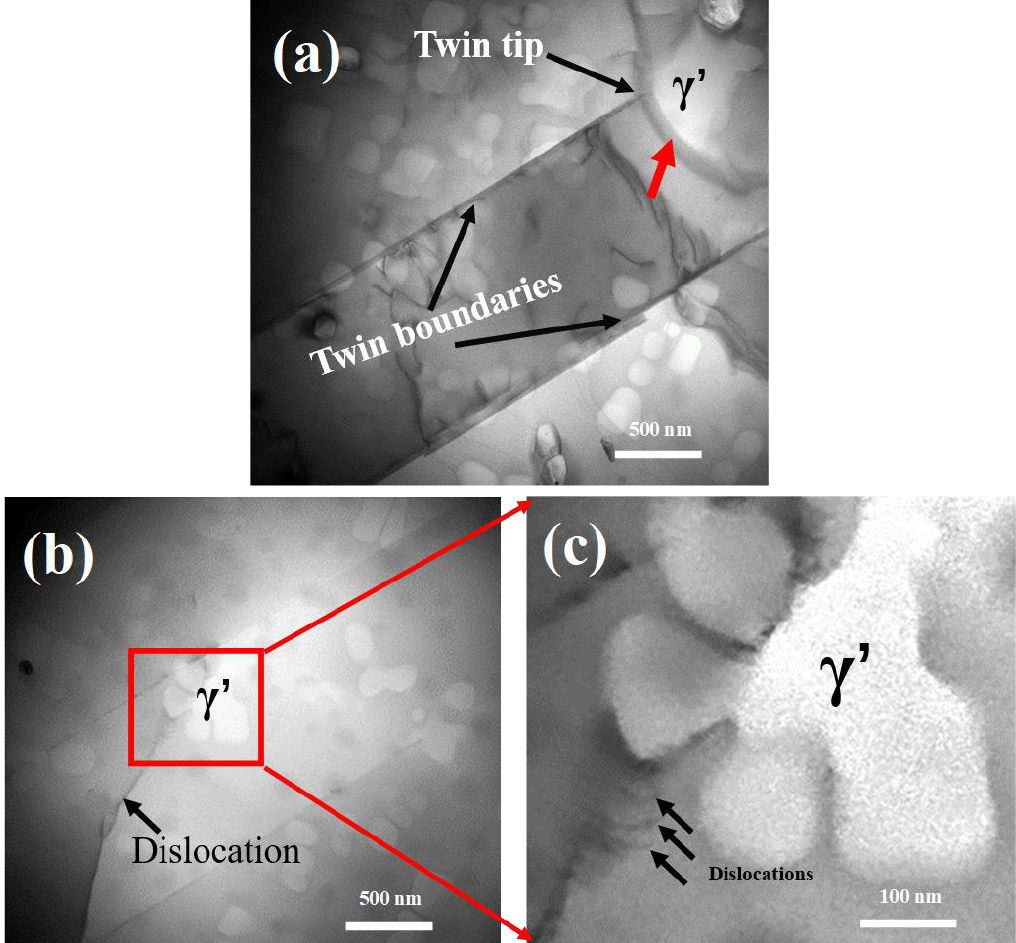
Figure 7. TEM images of FGH96 alloy after cooling to 1000 °C with cooling rate of 6 °C/min ( a ) the interaction of the twin tip and the γ’ precipitate; ( b ) the interaction of the dislocation and γ’ precipitate; ( c ) a magnification of the region in ( b ) marked by red rectangular. ( c ) a magnification of the region in ( b ) marked by red